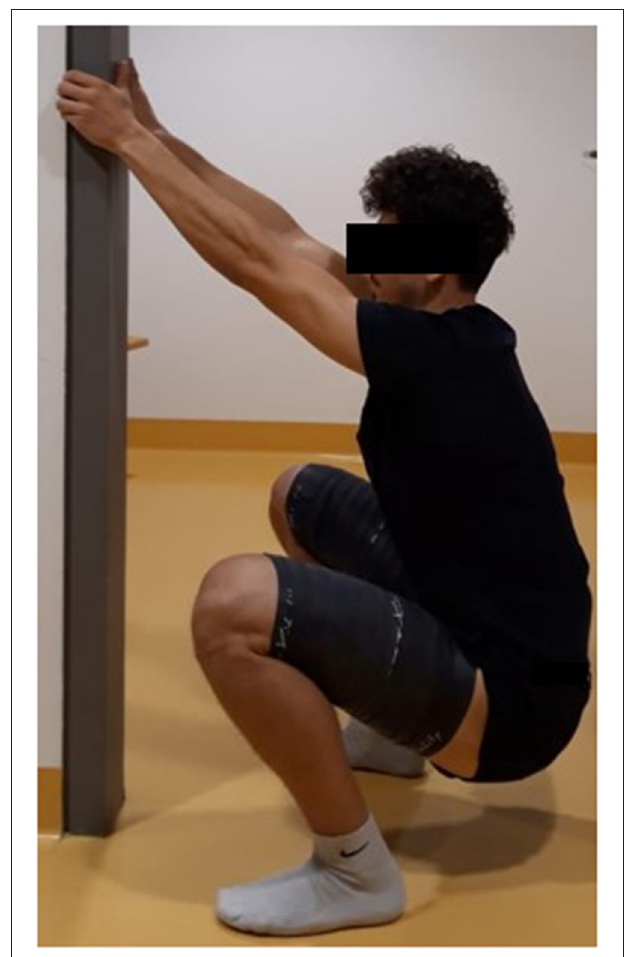
FIGURE 1 | Typical example of a floss band treatment, with the floss band wrapped around the thigh. An additional movement during the floss band treatment (e.g., deep squat during thigh flossing) should enhance the